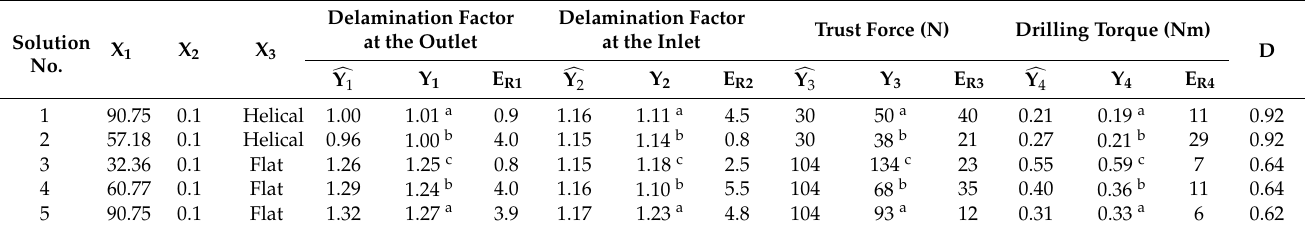
Table 10. The selected optimum solution of input factors and the corresponding numerical and experimental value of analyzed